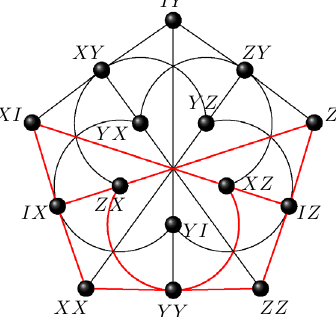
Figure 4. A Peres–Mermin square as a subgeometry of the doily. The square is the same as the one introduced in Fig. 1. It is a geometric hyperplane in the sense that a line of W ( 3, 2 ) is either contained in it (six such lines depicted in red) or has one point common with it (each of the remaining nine